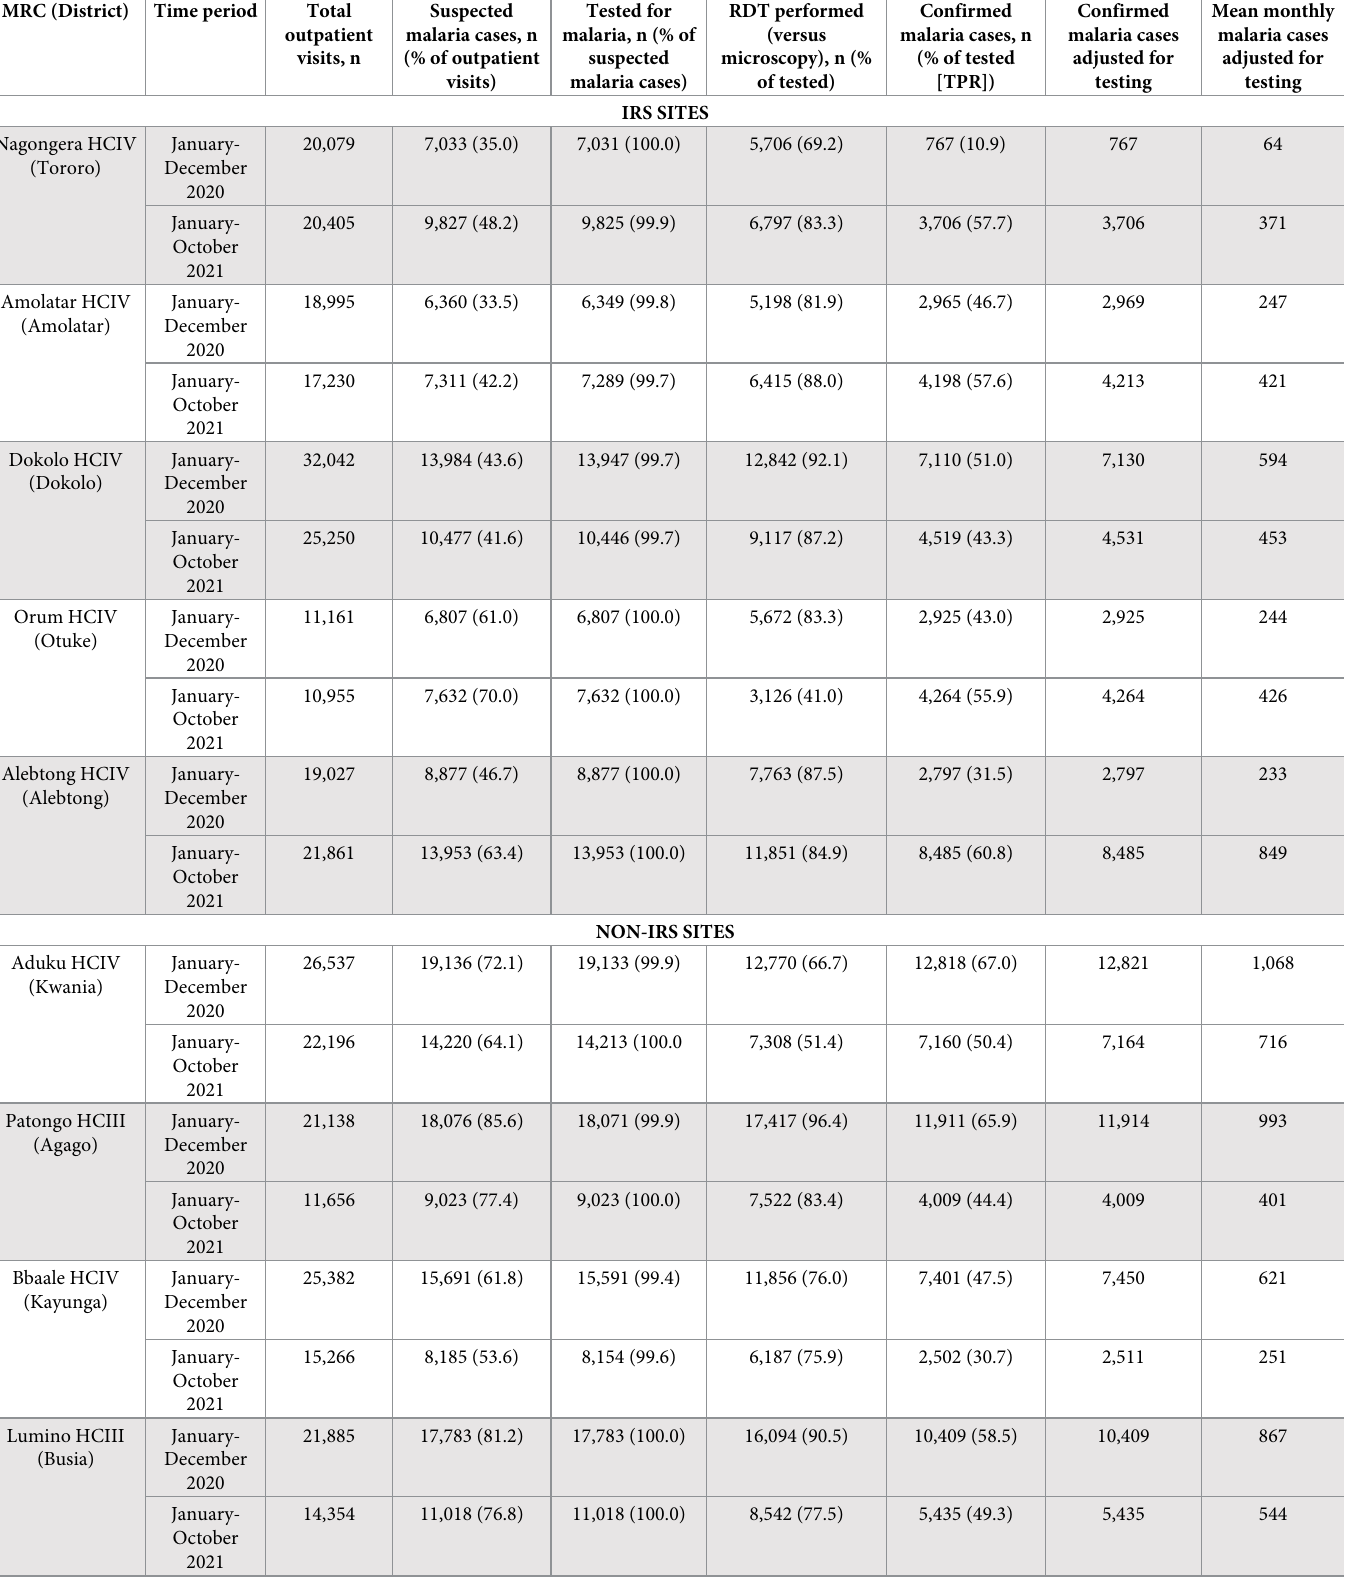
Table 2. Summary statistics from health-facility based surveillance sites for study objective 2. MRC (District) Time period Total